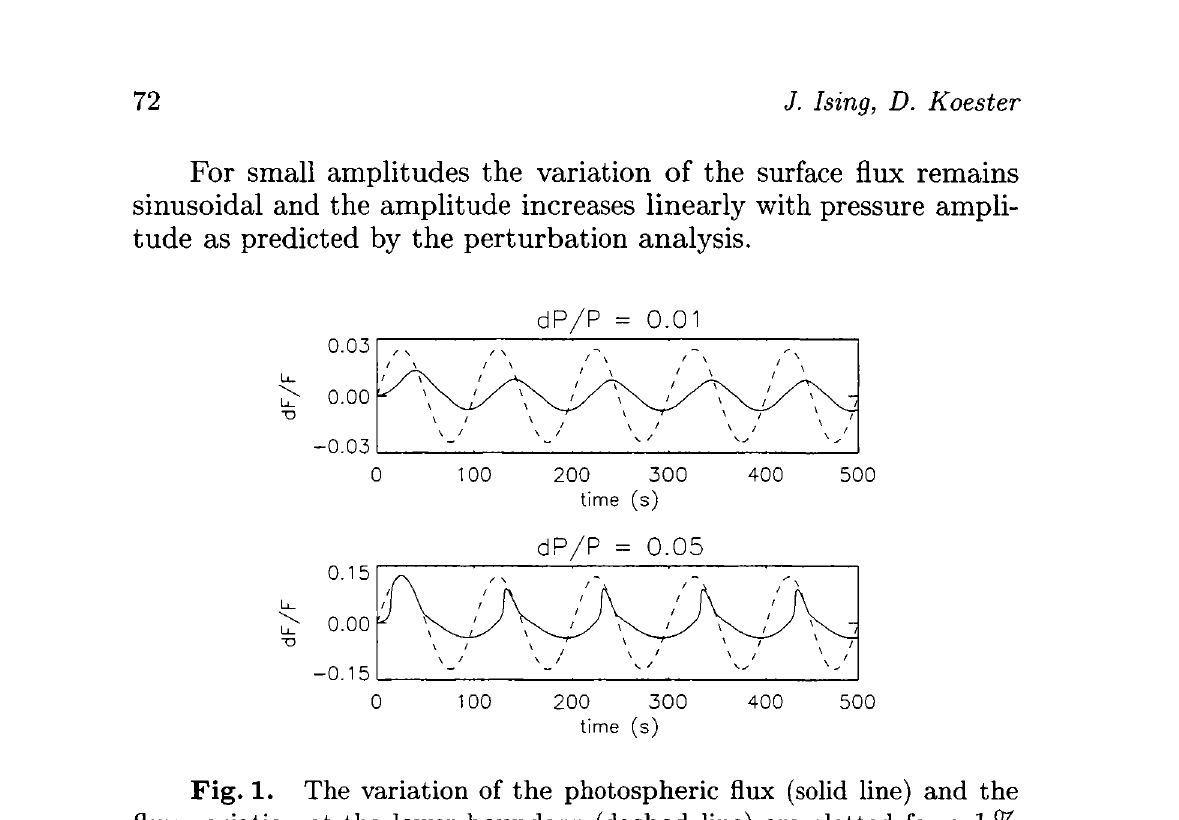
Fig. 1. The variation of the photospheric flux (solid line) and the flux variation at the lower boundary (dashed line) are plotted for a 1 % (upper panel) and a 5% pressure amplitude (lower